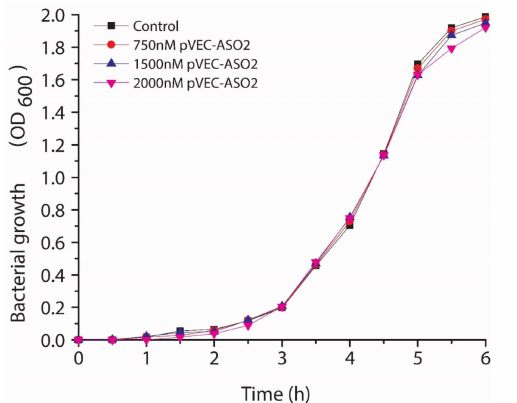
Figure 5. Testing the antibacterial activity of pVEC-ASO-2 with five mismatches compared with pVEC-ASO-1. There was no inhibition of the growth of S. aureus even at 2000